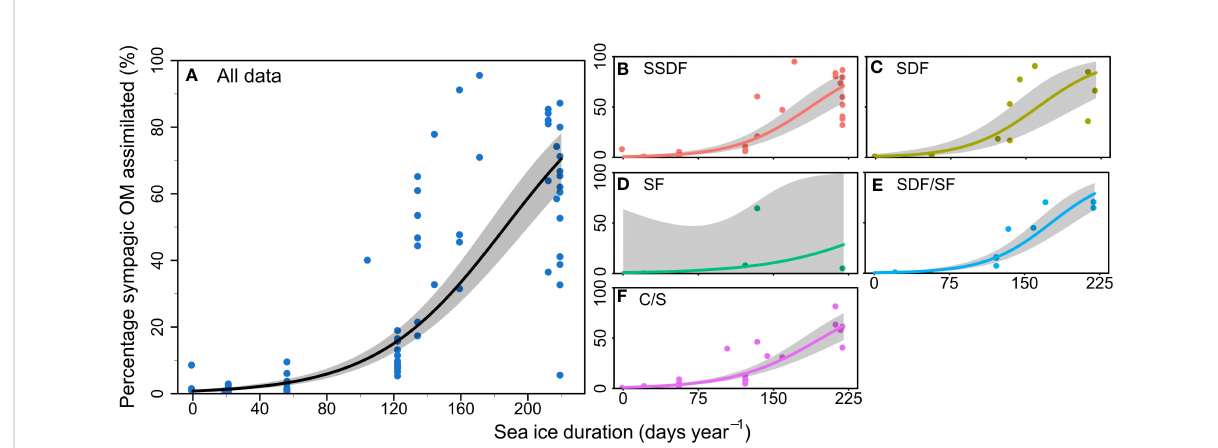
FIGURE 2 Proportion of sympagic organic matter (OM) assimilated based on the H-print approach against sea ice duration at each station during sampling period for (A) all samples analysed in the summer, and separated by feeding guilds: (B) subsurface deposit feeders; (C) surface deposit feeders; (D) suspension feeders; (E) surface deposit/suspension feeders; (F) carnivores/scavengers. Lines and shaded areas respectively represent regressions on logit-transformed data and 95% con fi dence intervals for each feeding guild. Each point represents one